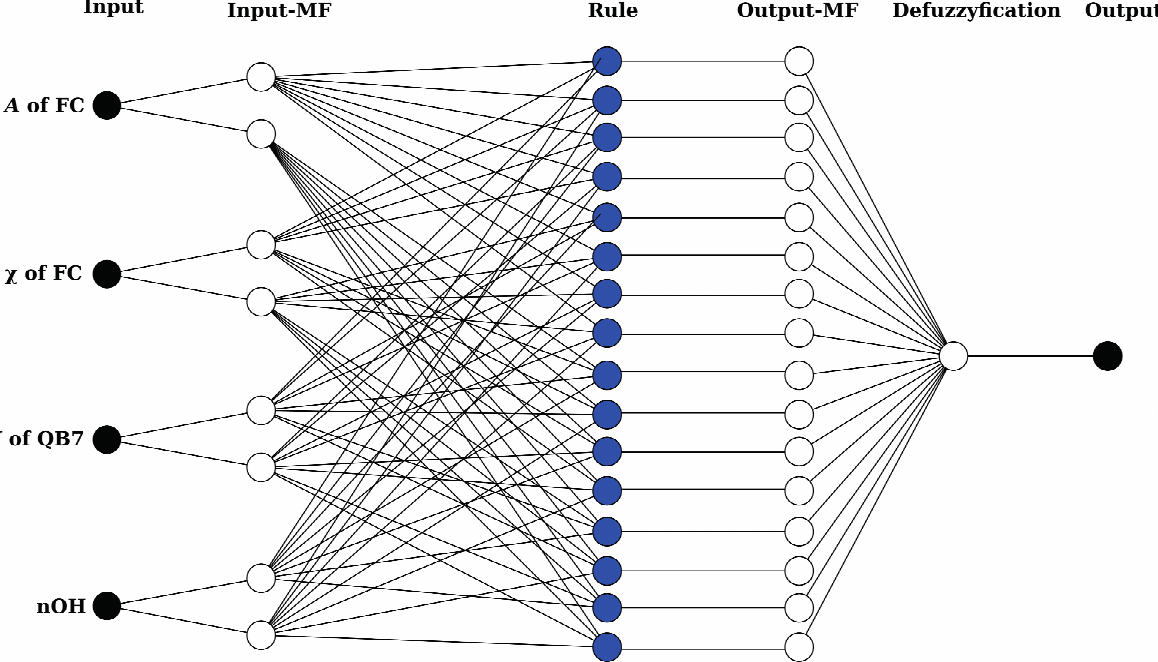
Figure 2. Developed adaptive neuro-fuzzy inference system (ANFIS)